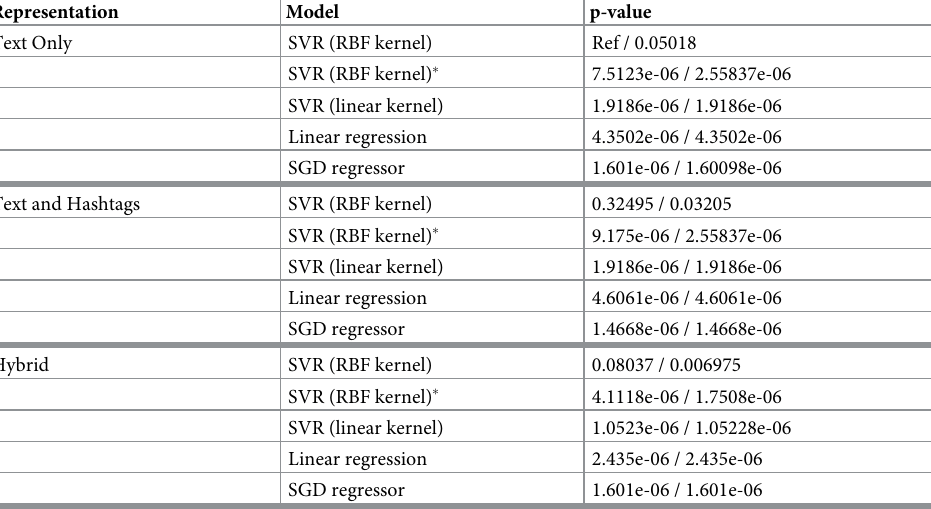
Table 5. One-sided p-values of each model’s Root Mean Square Error (RMSE) score, using the Student’s t-test, against the distribution of per-fold cross-validation means achieved by the best model in Table 4. The best model is the Text Only SVR (RBF Kernel) without sentiment , indicated as Ref below. The null hypothesis is that the mean of this best reference model is greater than (or in other words, worse than) the means shown in Column 4 of Table 4. Models specified with ( � ) do not include any zip code-level features. The p-values for the predictive models, with and without sentiment as a feature, are reported as without sentiment / with sentiment . Since cross-validation is not applica- ble for the constant-value baseline models, they are excluded in this